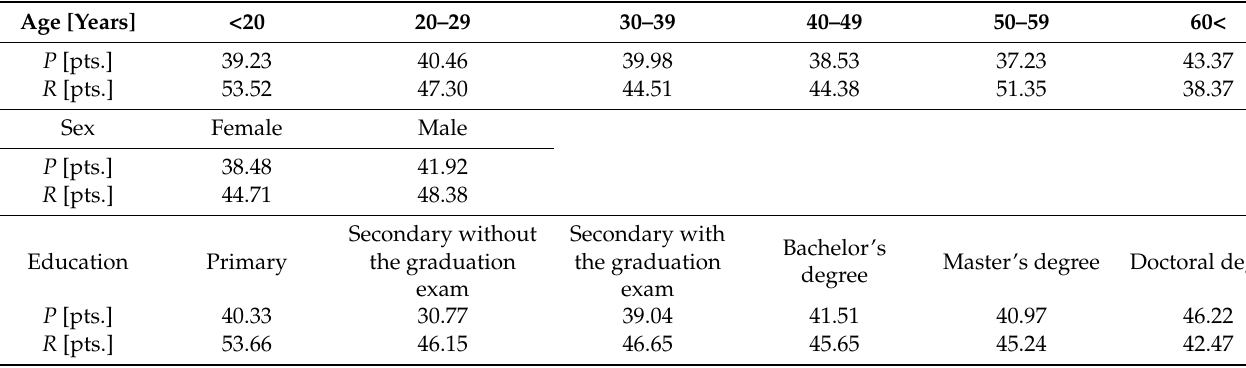
Table 6. Metrics P and R for individual sorting